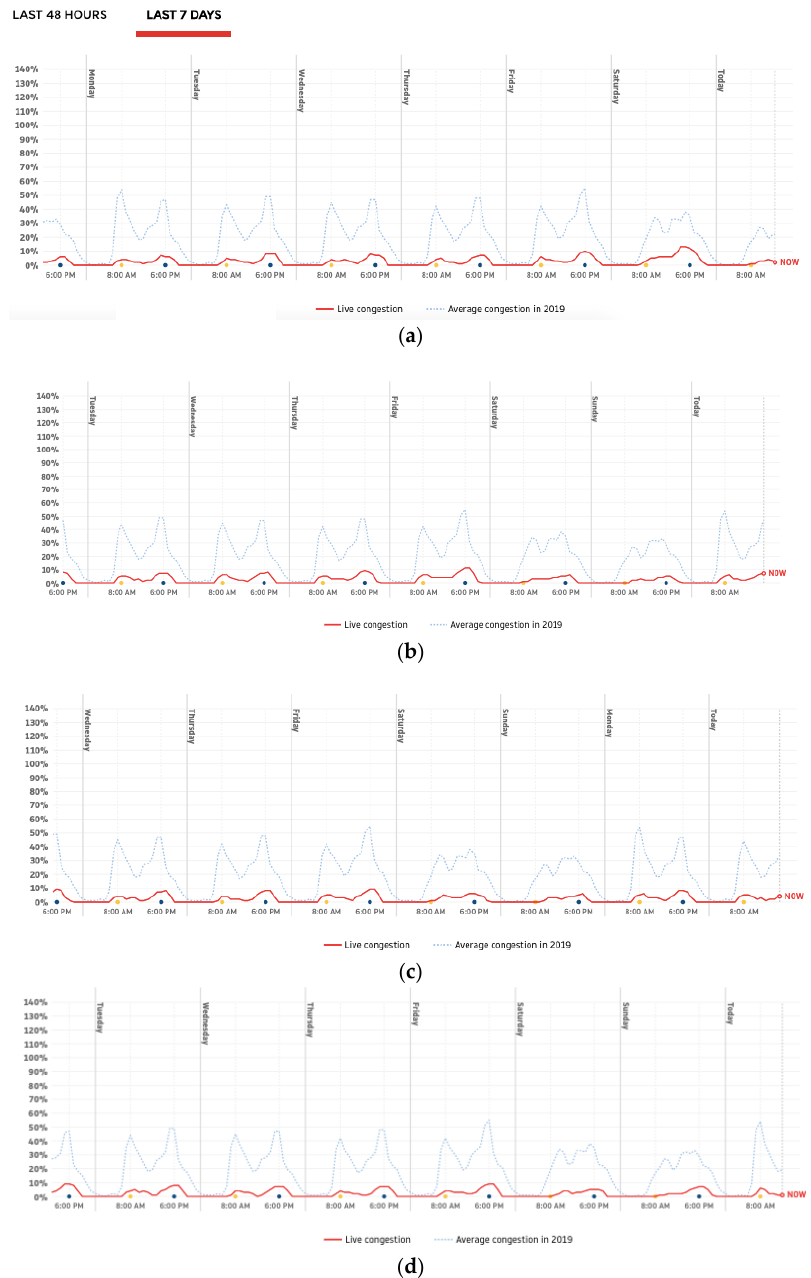
Figure 15. TomTom traffic congestion index during the COVID-19 lockdown of Wuhan: ( a ) 10/02/2020 – 16/02/2020, ( b ) 19/02/2020 – 25/02/2020, ( c ) 25/02/2020 – 02/03/2020, and ( d ) 02/03/2020 –